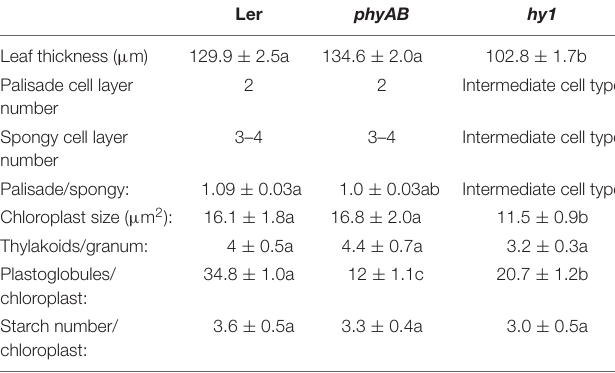
TABLE 2 | Characteristics of leaf anatomy and chloroplast ultrastructures in WT, phyAB, and hy1